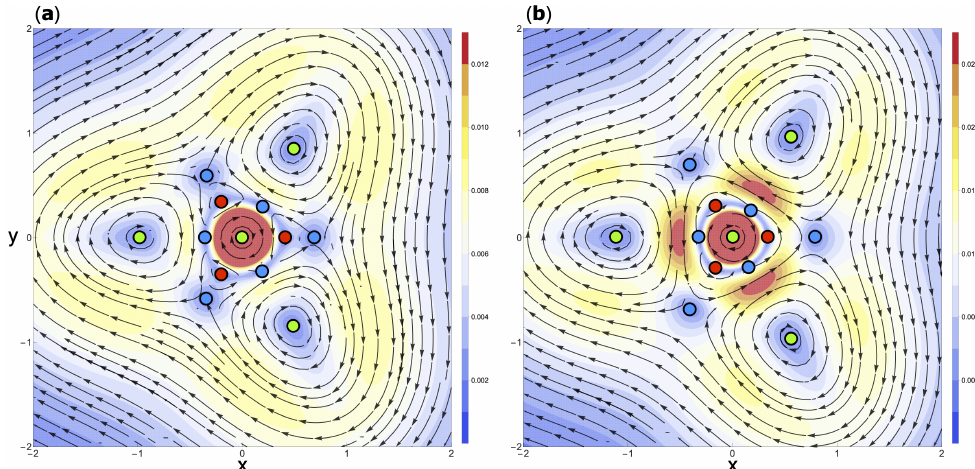
Figure 8. Streamline plots of the current density j , with contours of its norm, in the xy plane of the CH 4 molecule in a magnetic field of ( a ) 0.1 B 0 and ( b ) 0.2 B 0 along the z -axis. Paratropic vortex lines are shown as red circles, diatropic vortex lines as green circles and saddle lines as blue